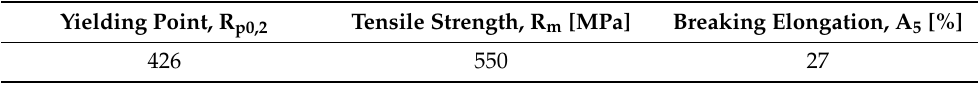
Table 3. Mechanical characteristics of HSLA EH36 steel.